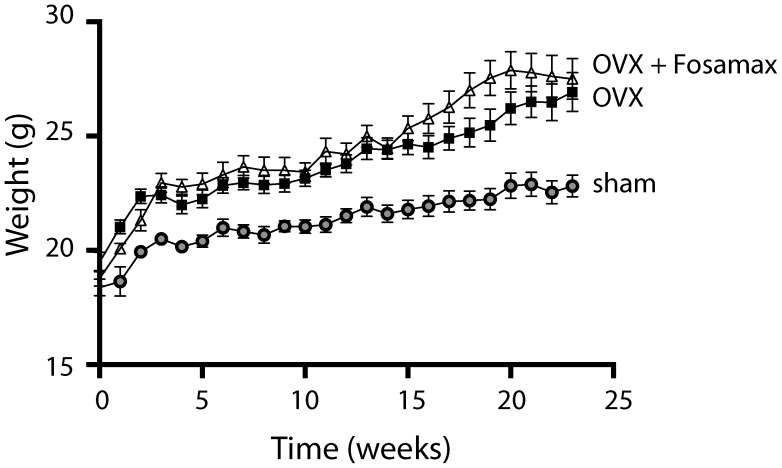
Body weight of mice over 23 weeks.Body weight of sham (circle), OVX (square), and OVX + Fosamax (triangle) C57BL/6 mice over 23 weeks. Time 0 represents the time of surgery. Analyzed by 2-way analysis of variance (ANOVA). Each value is expressed as mean ± SEM.